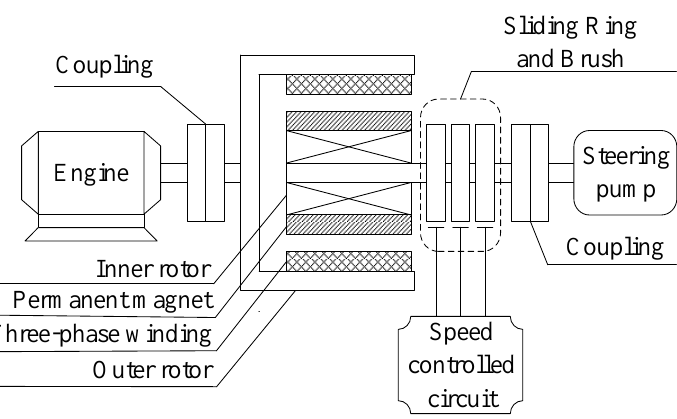
Figure 2. Structure diagram of PMSC.